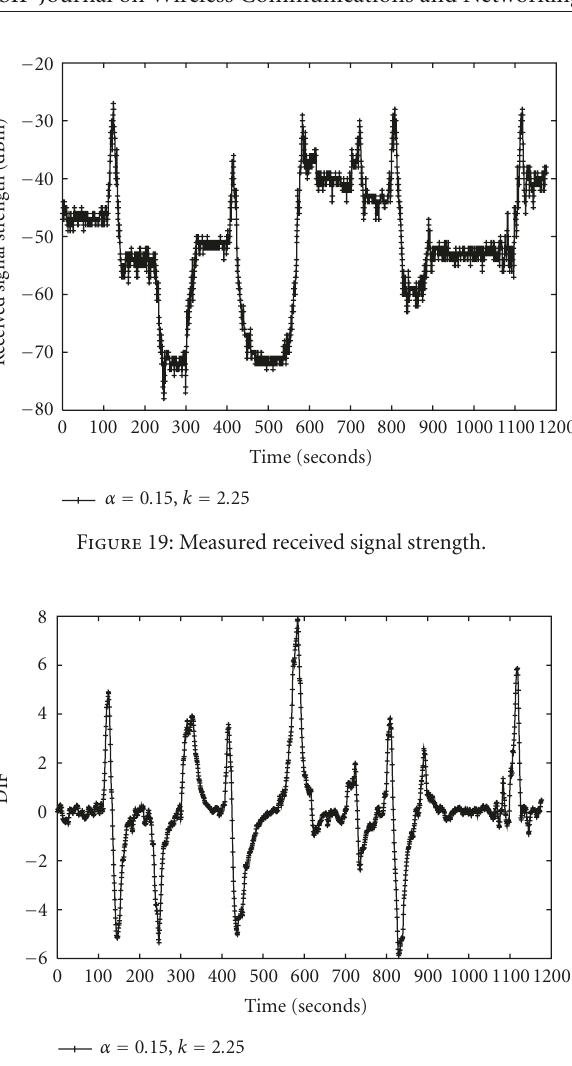
Figure 20: Variation in DIF value throughout